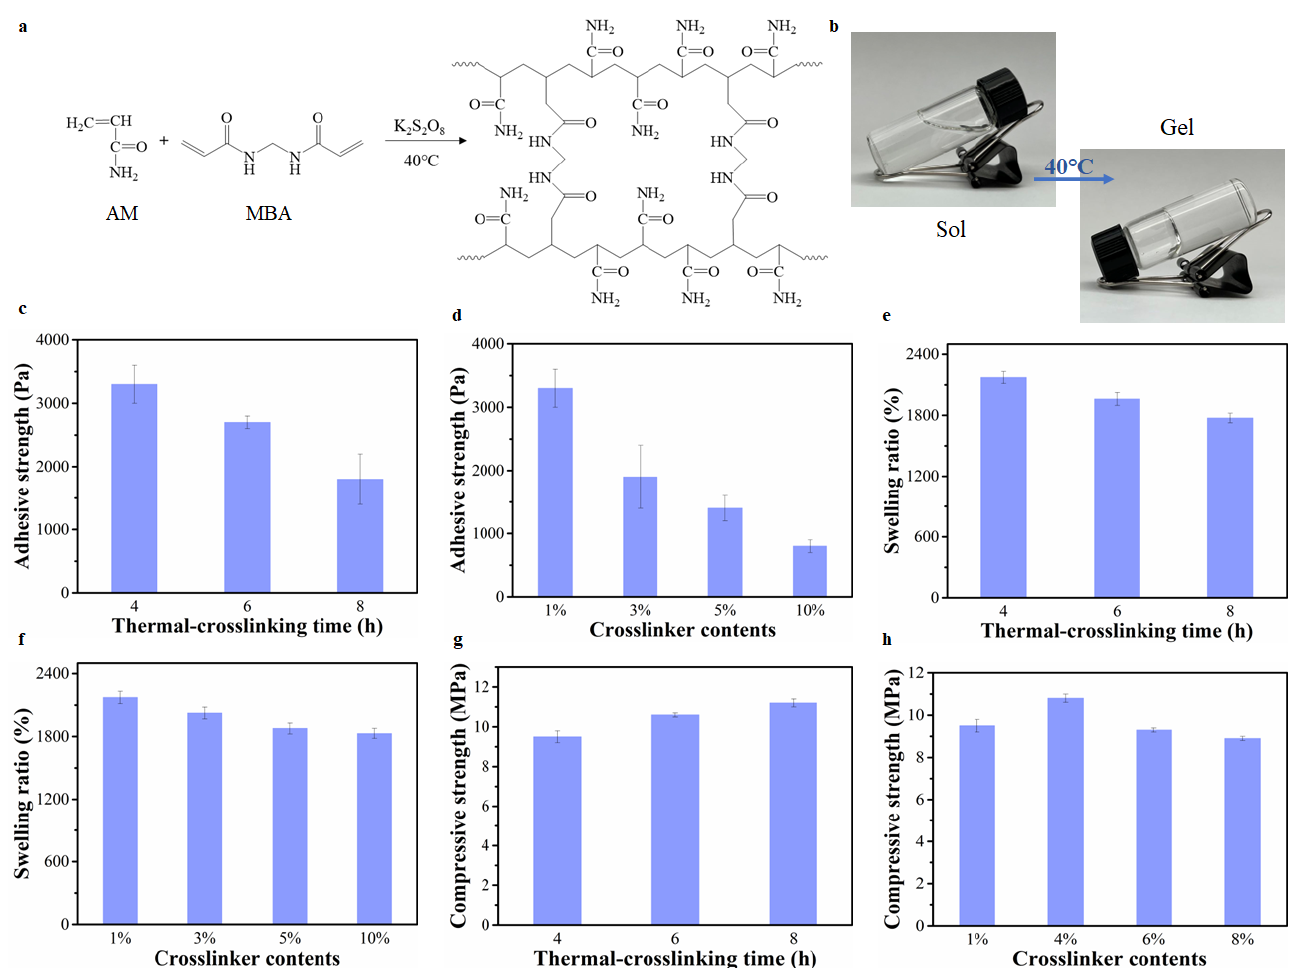
Figure 2. ( a ) The formation mechanism of PAM hydrogels. ( b ) The preparation process of PAM hydrogels. ( c ) The adhesive strength of PAM hydrogels prepared by different thermal-crosslinking times. ( d ) The adhesive strength of PAM hydrogels prepared with different crosslinker contents. ( e ) The swelling ratio of PAM hydrogels prepared by different thermal-crosslinking times. ( f ) The swelling ratio of PAM hydrogels prepared with different crosslinker contents. ( g ) The compressive strength of PAM hydrogels prepared by different thermal-crosslinking times. ( h ) The compressive strength of PAM hydrogels prepared with different crosslinker